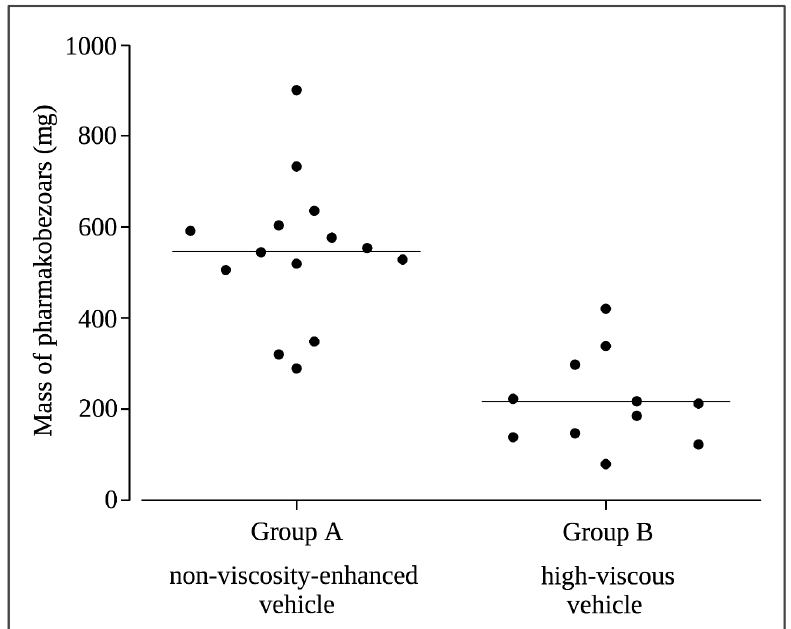
Figure 10. Mass of pharmacobezoars at necropsy after 24 days dosing of 2400 mg/kg/day BI 1026706 SD-ASD suspended in non-viscosity-enhanced vehicle (Group A) and high-viscous vehicle (Group B); mean values are indicated by horizontal line.